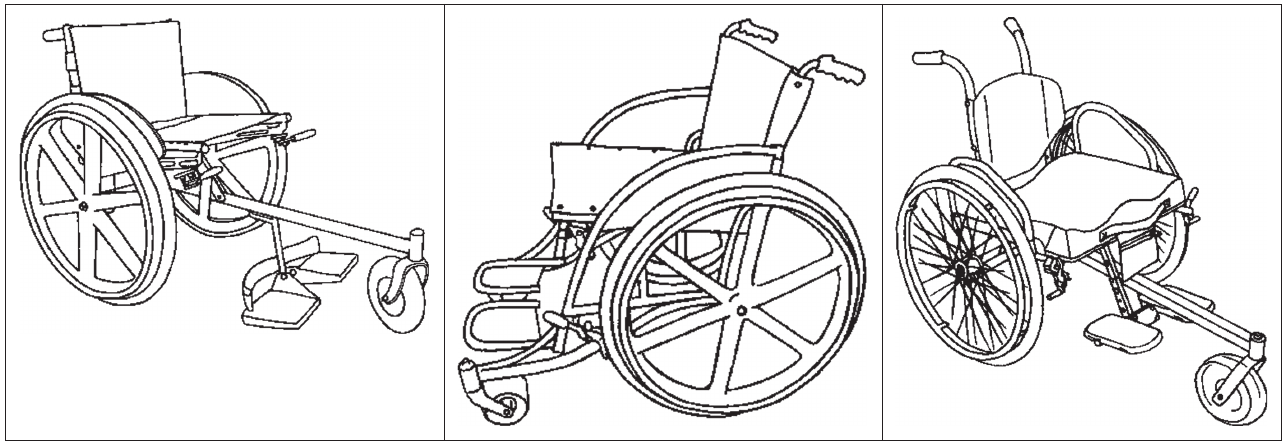
Source : Figure provided by Elsje Scheffler; © Motivation FIGURE 7: Examples of wheelchair designs referred to in the studies by Visagie et al. (2015) and Rispin and Wee